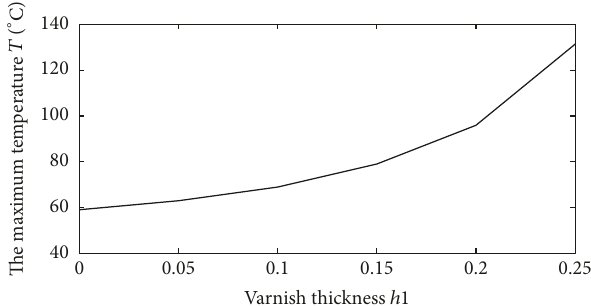
Figure 12: Variation of the maximum oil temperature with varnish thickness.